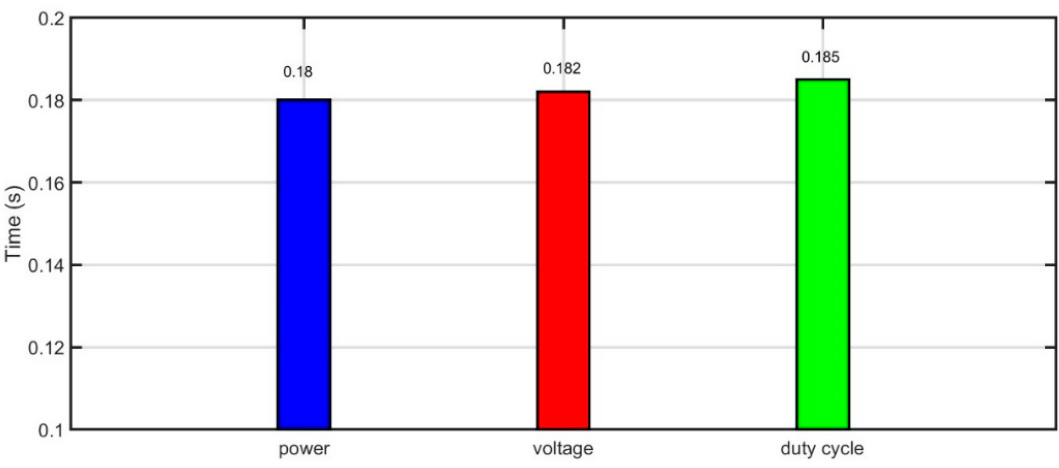
Figure 20. The steady-state restoration time using the cuckoo search method.